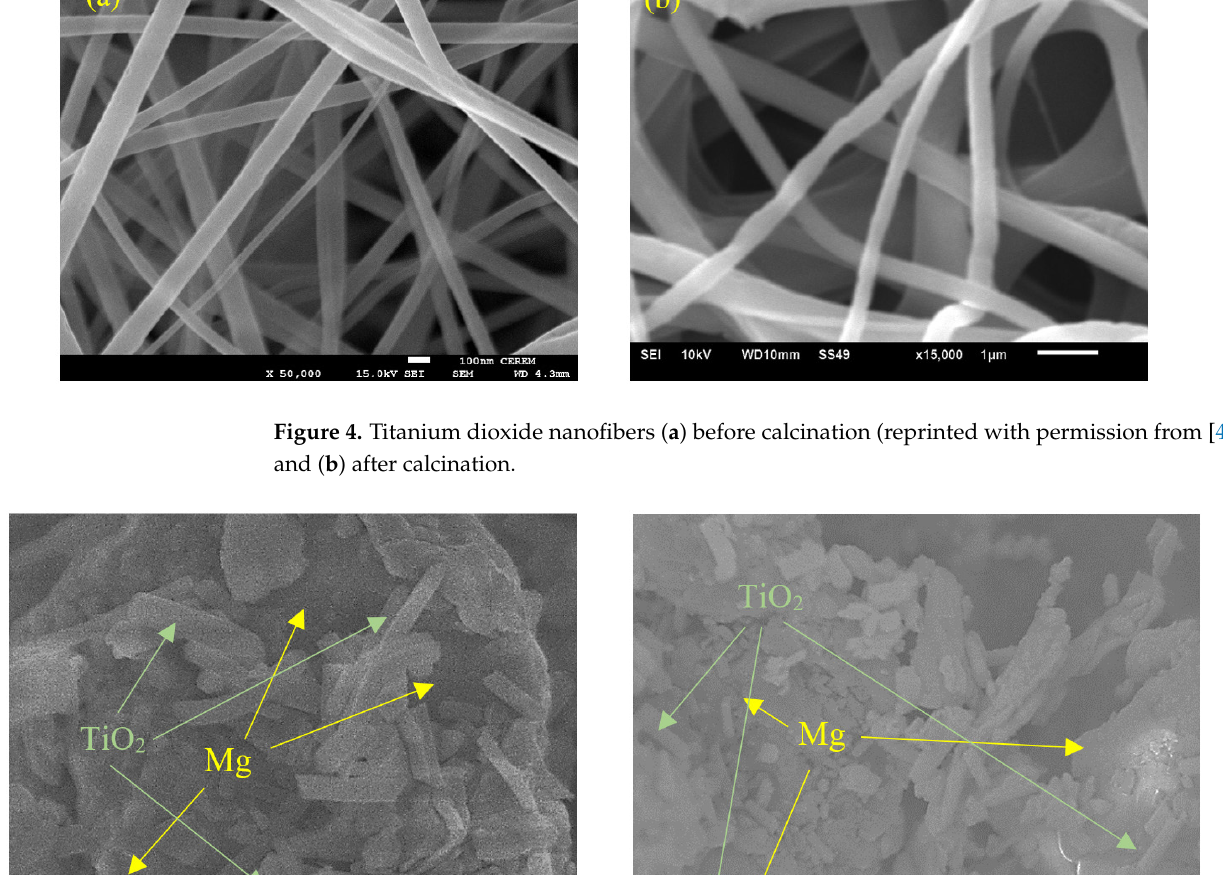
6 of 15 Figure 3. Schematic diagram for the wear test.